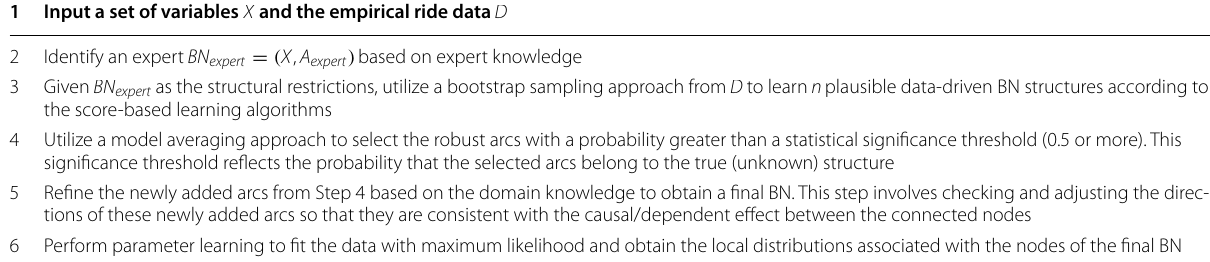
Table 4 Hybrid BN structure‑learning